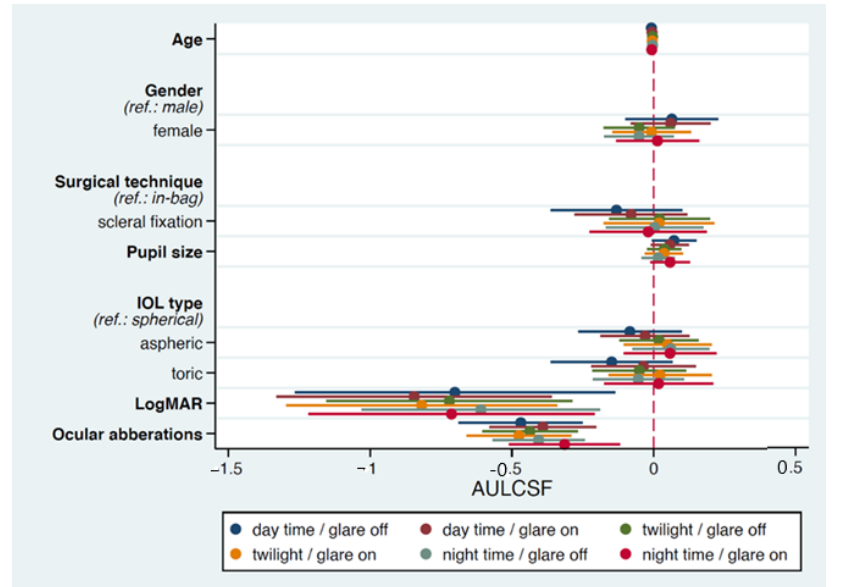
Figure 1. Forest plot depicts the coefficient of each factor and its 95% confidence interval (CI) in a multiple regression analysis for factors associated with contrast sensitivity. The x-axis represents the reference line (dashed), the value of coefficient (dot), and 95% CI (strip). AULCSF = area under the log contrast sensitivity function; IOL = intraocular lens; LogMAR = logarithm of the minimum angle of resolution. Table 4. Multivariate generalized estimating equation (GEE) analysis of contrast sensitivity under every luminance condition with or without glare interference.